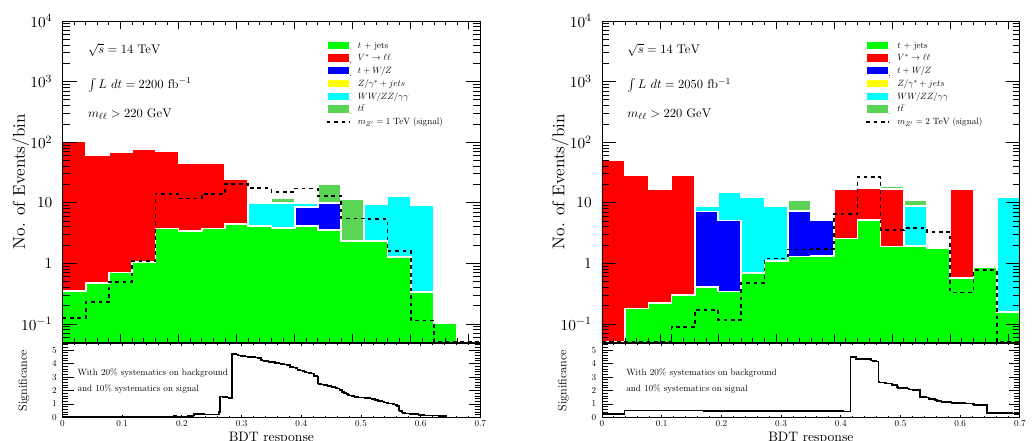
Figure 10 . Signal and background event distribution in the ‘BDT response’ variable obtained after training and testing the BDT on the background and signal samples. The model points are the same as in figure 9. The bottom plots show the significance given by eq. (5.2) as a result of applying cuts on the ‘BDT response’. Here, both model points are discoverable at the